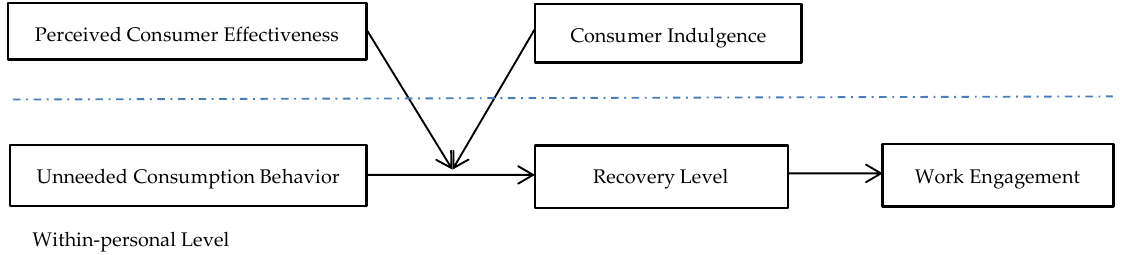
Figure 1. Theoretical Framework.